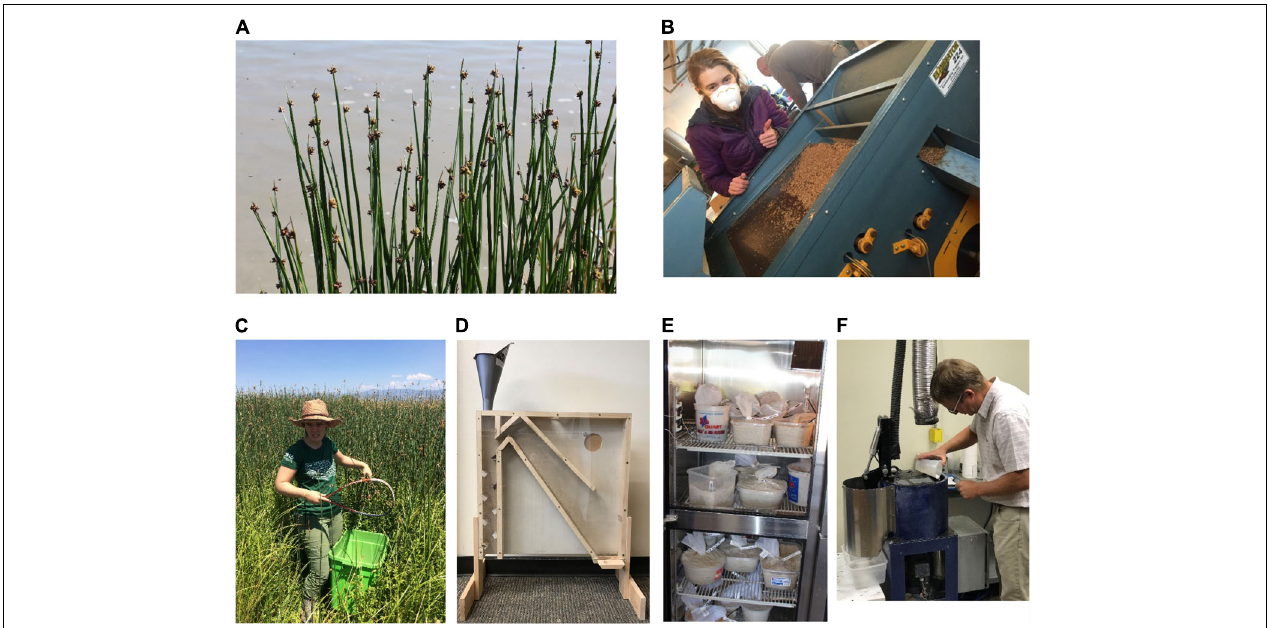
FIGURE 5 | (A) Mature seed of three-square bulrush ( Schoenoplectus americanus (Pers.) Volkart ex Schinz & R. Keller) ready for harvesting; (B) seed sorting based on gravity and sieve size; (C) seed collecting of hardstem bulrush ( Schoenoplectus acutus ) with a tennis racquet; (D) air column separator for seed cleaning; (E) wetland seeds in cold, moist stratification in a refrigerator; and (F) Dr. Matt Madsen coating wetland seeds with a surfactant seed coating (diatomaceous earth, SelvolTM polyvinyl alcohol binder, and AquatrolsTM SET 4001 surfactant) in his lab at Brigham Young University, Provo, Utah, United States. The coating is intended to improve germination of seeds under reduced soil moisture